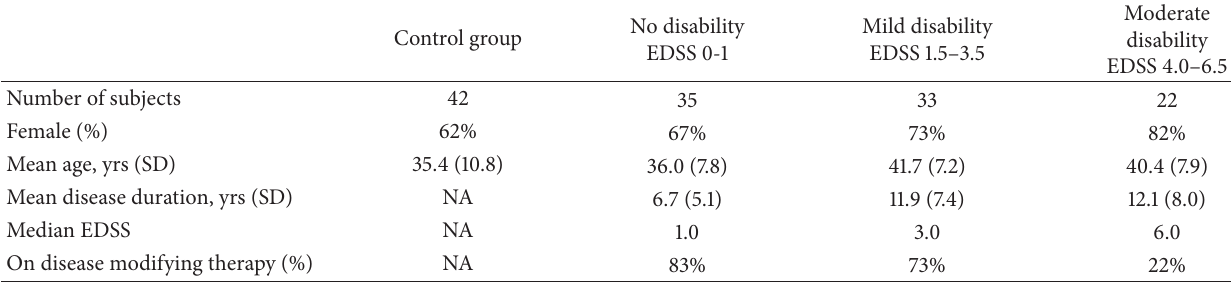
Table 1: Patient characteristics.